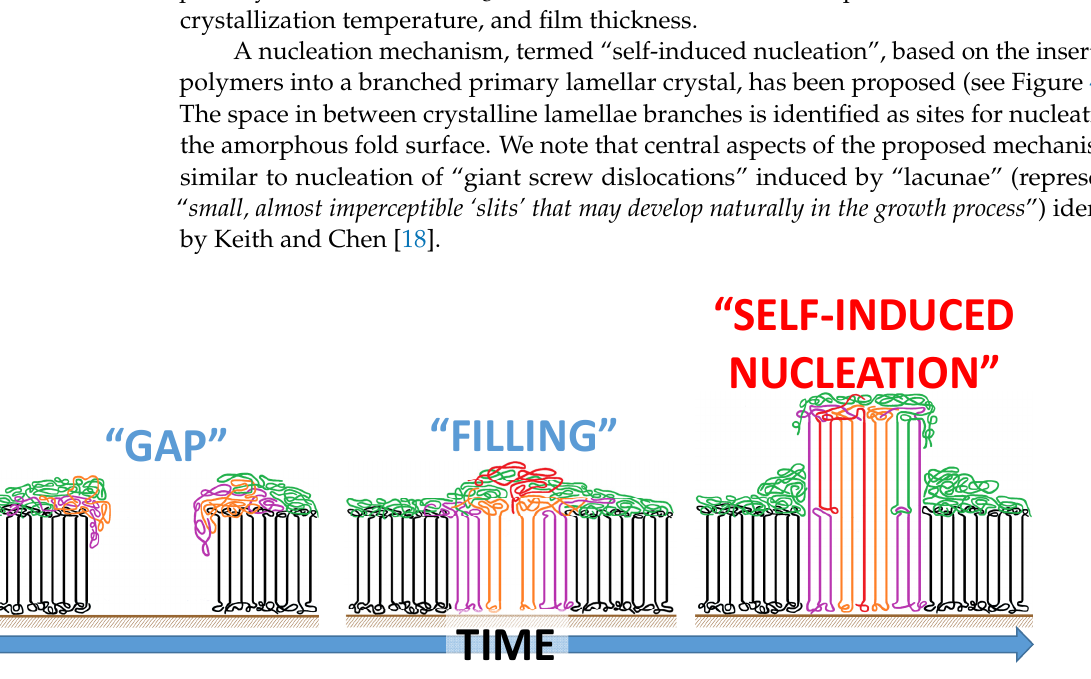
Figure 4. Scheme demonstrating self-induced nucleation, a new mechanism for the formation of secondary lamellar crystals, insertion of polymer chains in the impinging corner of two primary branches. Adapted from ref [22].